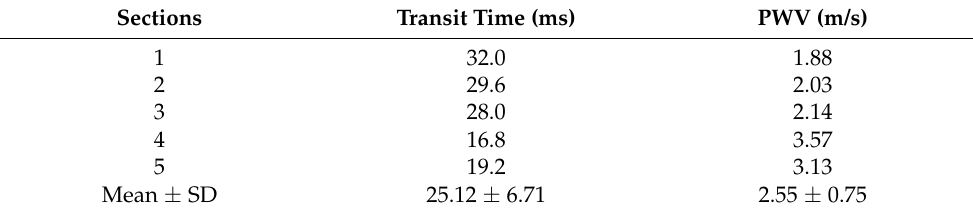
Table 2. Transit times ( ∆ t) and PWVs calculated from the sectional pulse waveforms. Sections